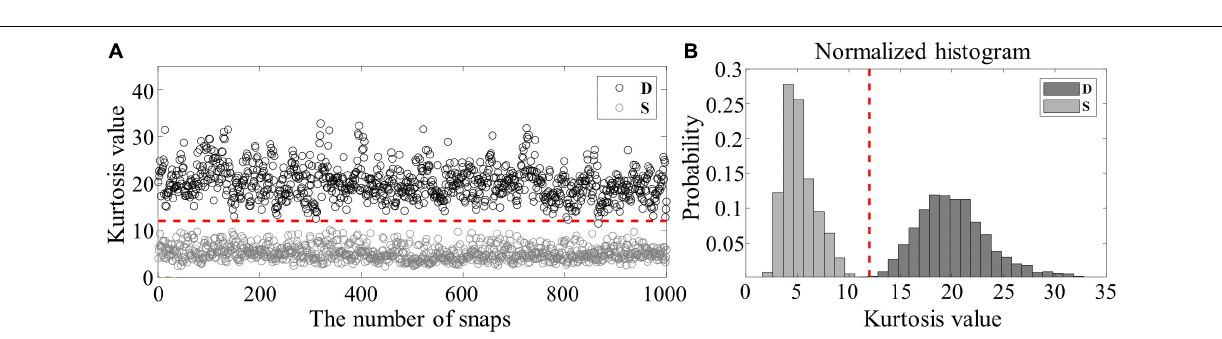
FIGURE 5 | (A) Kurtosis values estimated from 1,000 waveforms for direct (D, black circles) and sea-surface reflected (S, gray circles) paths, which were collected by the bottom hydrophone of VLA1 for 30 min from JD 142 at 00:00 UTC. (B) Corresponding normalized histograms of kurtosis values for D (dark) and S (gray), respectively. The red vertical line denotes the kurtosis value of 11.2, which was selected as the criterion to filter out the S